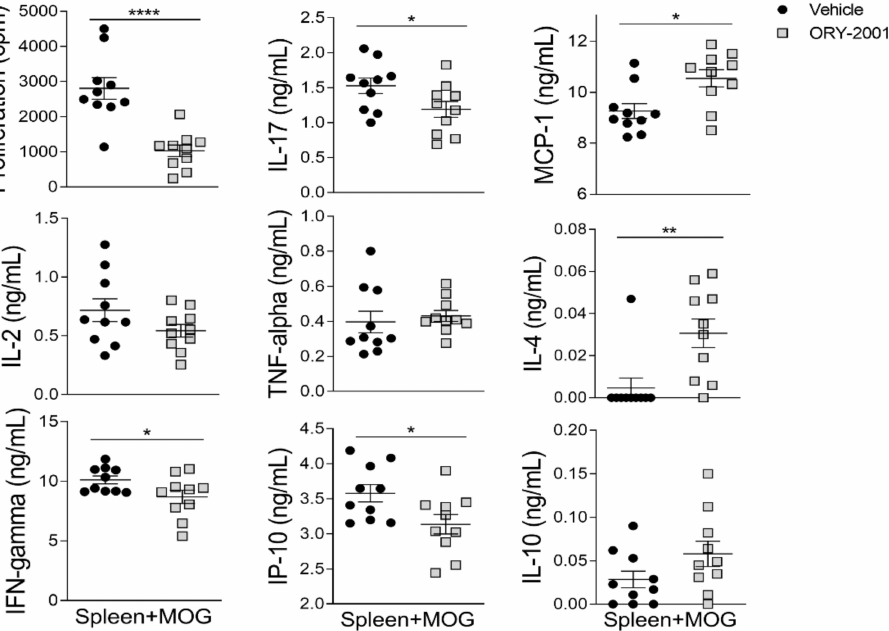
Figure 3. Treatment with ORY-2001 deactivates encephalitogenic T-cell responses in vitro. Prolif- erative response and cytokine/chemokine production by spleen cells isolated from mice suffering chronic EAE at the peak of the disease and then re-stimulated with MOG 35–55 (15 µ M) in the absence (vehicle) or presence of 0.5 µ M ORY-2001 (i.e., 5 × IC 50 for KDM1A, sufficient for full inhibition). N = 10/group. * p < 0.05, ** p < 0.01, **** p < 0.0001 between vehicle and ORY-2001. Data are the mean ± SEM with dots representing individual values of biologically independent